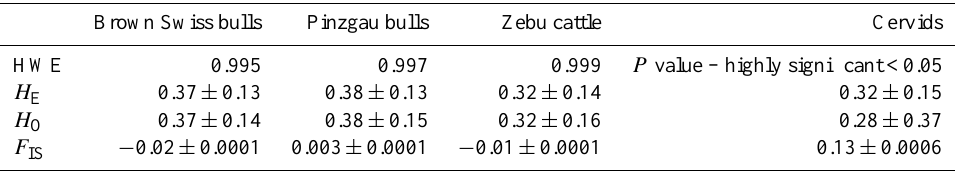
Table 2. HWE p values, expected ( H e ) and observed ( H o ) heterozygosity and fixation indexes ( F IS ) .